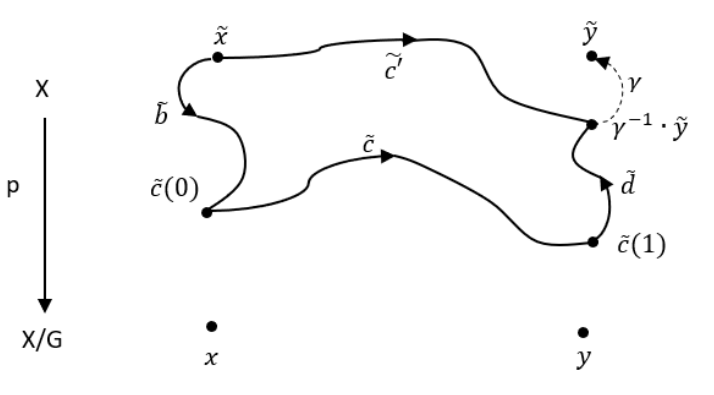
Figure 2. A visual representation of the paths involved in the proof of Theorem